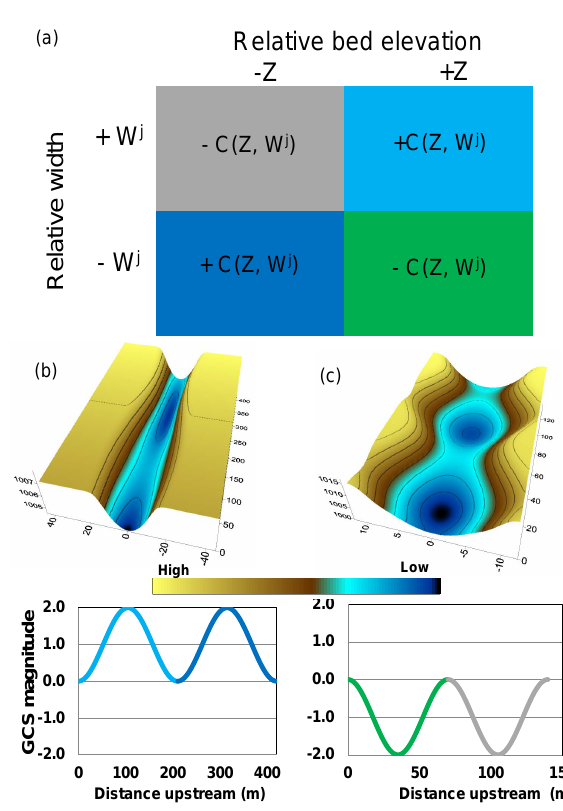
(cid:16) (cid:17) ZW j geomorphic (cid:16) (cid:17) ZW j colored according to